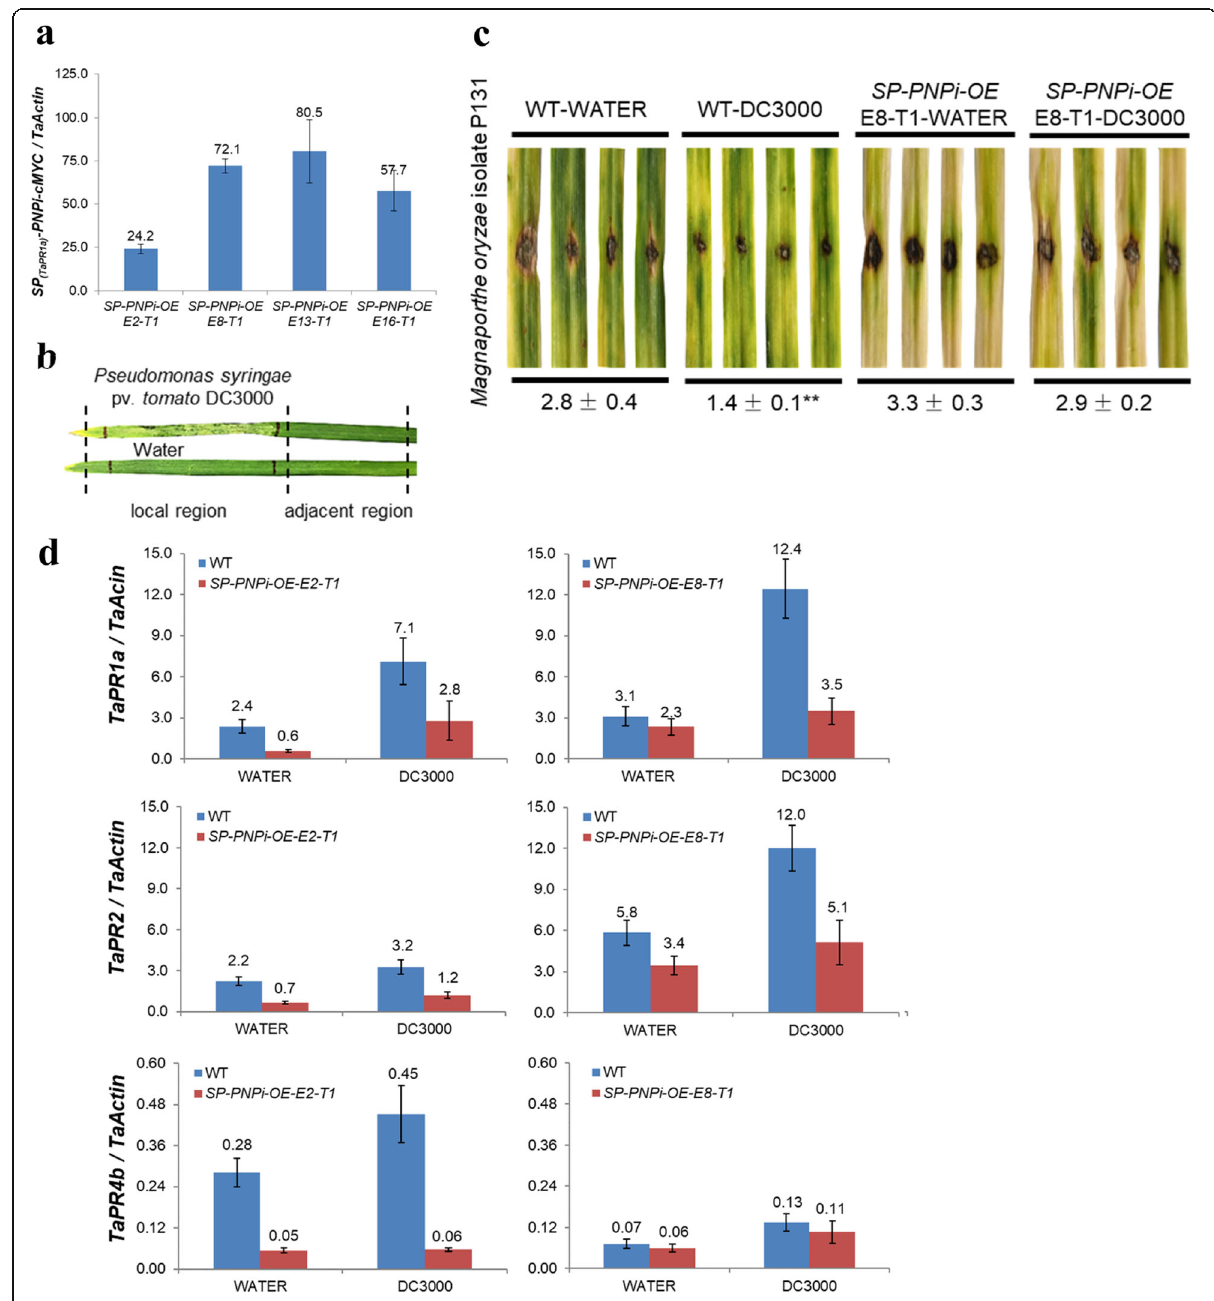
Fig. 5 The NPR1 -mediated acquired resistance to Magnaporthe oryzae isolate P131 was suppressed in the transgenic wheat line SP-PNPi-OE. a Expression levels of the SP (TaPR1a) -PNPi-cMYC transgene in the transgenic wheat line SP-PNPi-OE were determined by RT-qPCR. b P. syringae DC3000 was employed to induce the acquired resistance in the region adjacent to the infiltration area. c The M. oryzae isolate P131 was inoculated in the adjacent region as a secondary pathogen to evaluate the degree of the acquired resistance. The numbers below the images of the leaves represent the average lesion size caused by M. oryzae . d The expression levels of TaPR1a , TaPR2 , and TaPR4b in transgenic wheat line SP-PNPi-OE and wild-type plants during acquired resistance were determined by RT-qPCR. The whole experiment was repeated twice using two independent transgenic lines of SP-PNPi-OE . Statistical analyses are presented in Additional file 1: Table